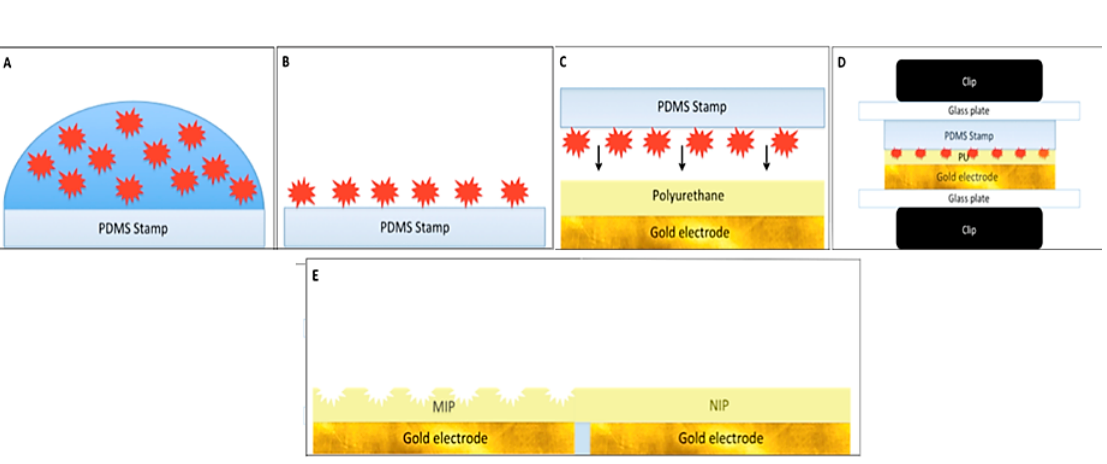
Figure 1. Procedure steps leading to MIP sensors: ( A ) Thrombocytes in buffer solution adhering onto a PDMS stamp ( B ) Thrombocytes bind non-covalently to the stamp; ( C , D ) Template cells are tightly pressed onto a gold electrode ( E ) Imprints are established, template cells are washed off. One electrode is imprinted with thrombocyte (MIP), while the other is not (NIP).